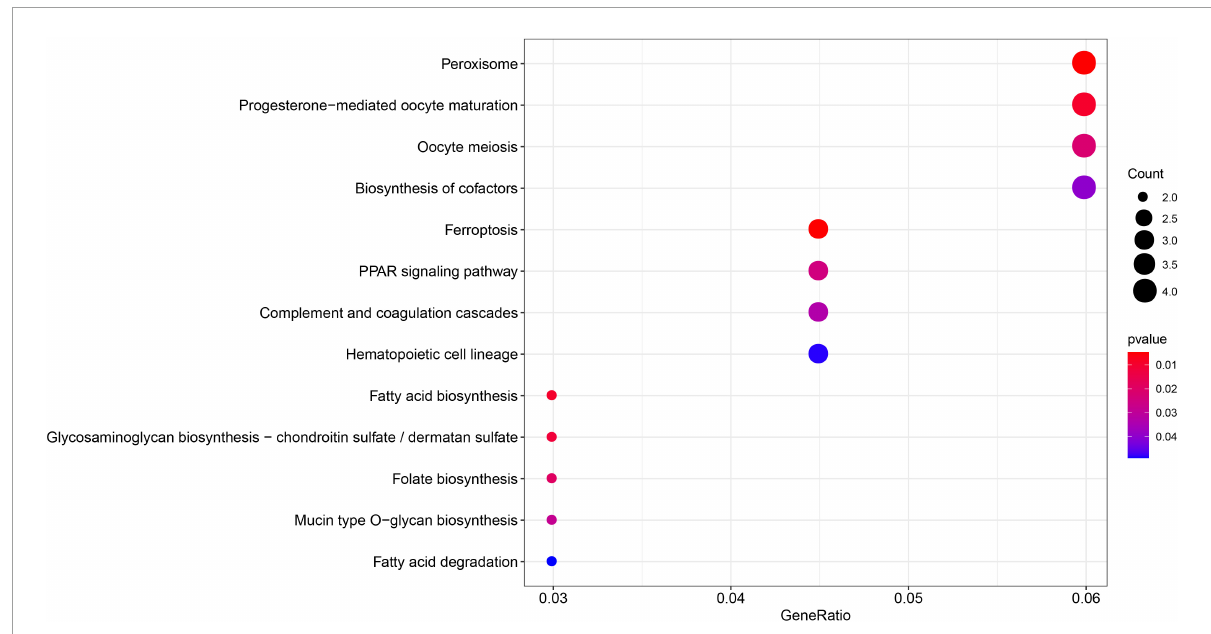
FIGURE9 Kyoto encyclopedia of genes and genomes enrichment of 149 MEgreenyellow genes. The count shows the number of genes enriched in the pathway. Gene ratio: the ratio of the gene number in this term to the total number of the MEgreenyellow module.